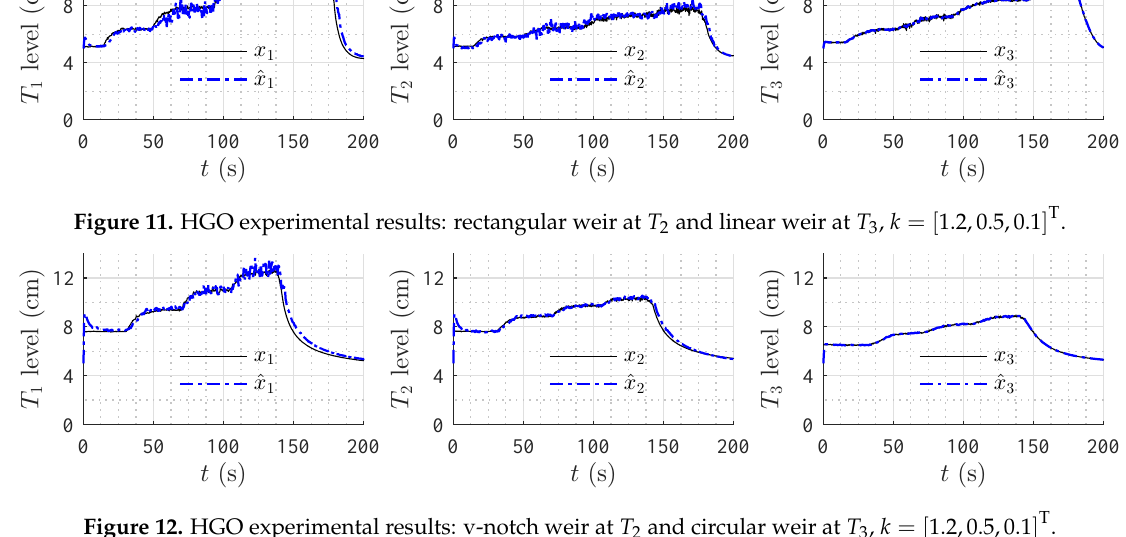
Figure 12. HGO experimental results: v-notch weir at T 2 and circular weir at T 3 , k = [ 1.2,0.5,0.1 ] T